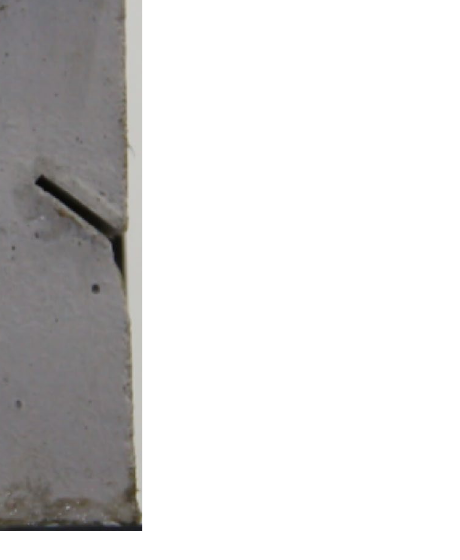
Figure 2. Finished specimen before